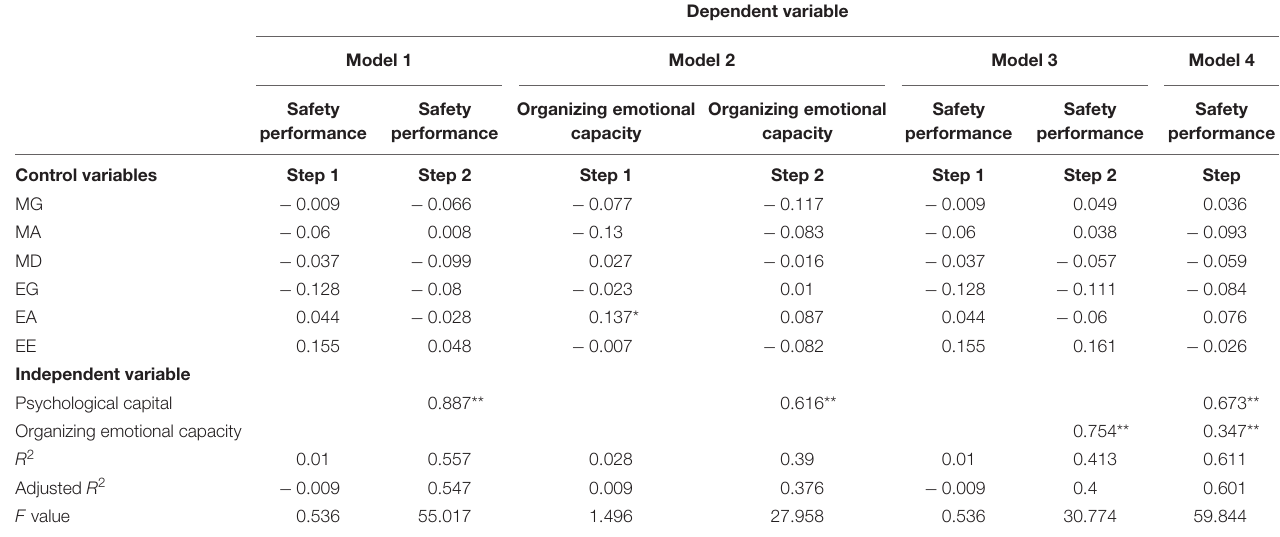
TABLE 7 | Regression analysis of the relationship between management psychological capital, Organizing emotional capacity, and employee safety